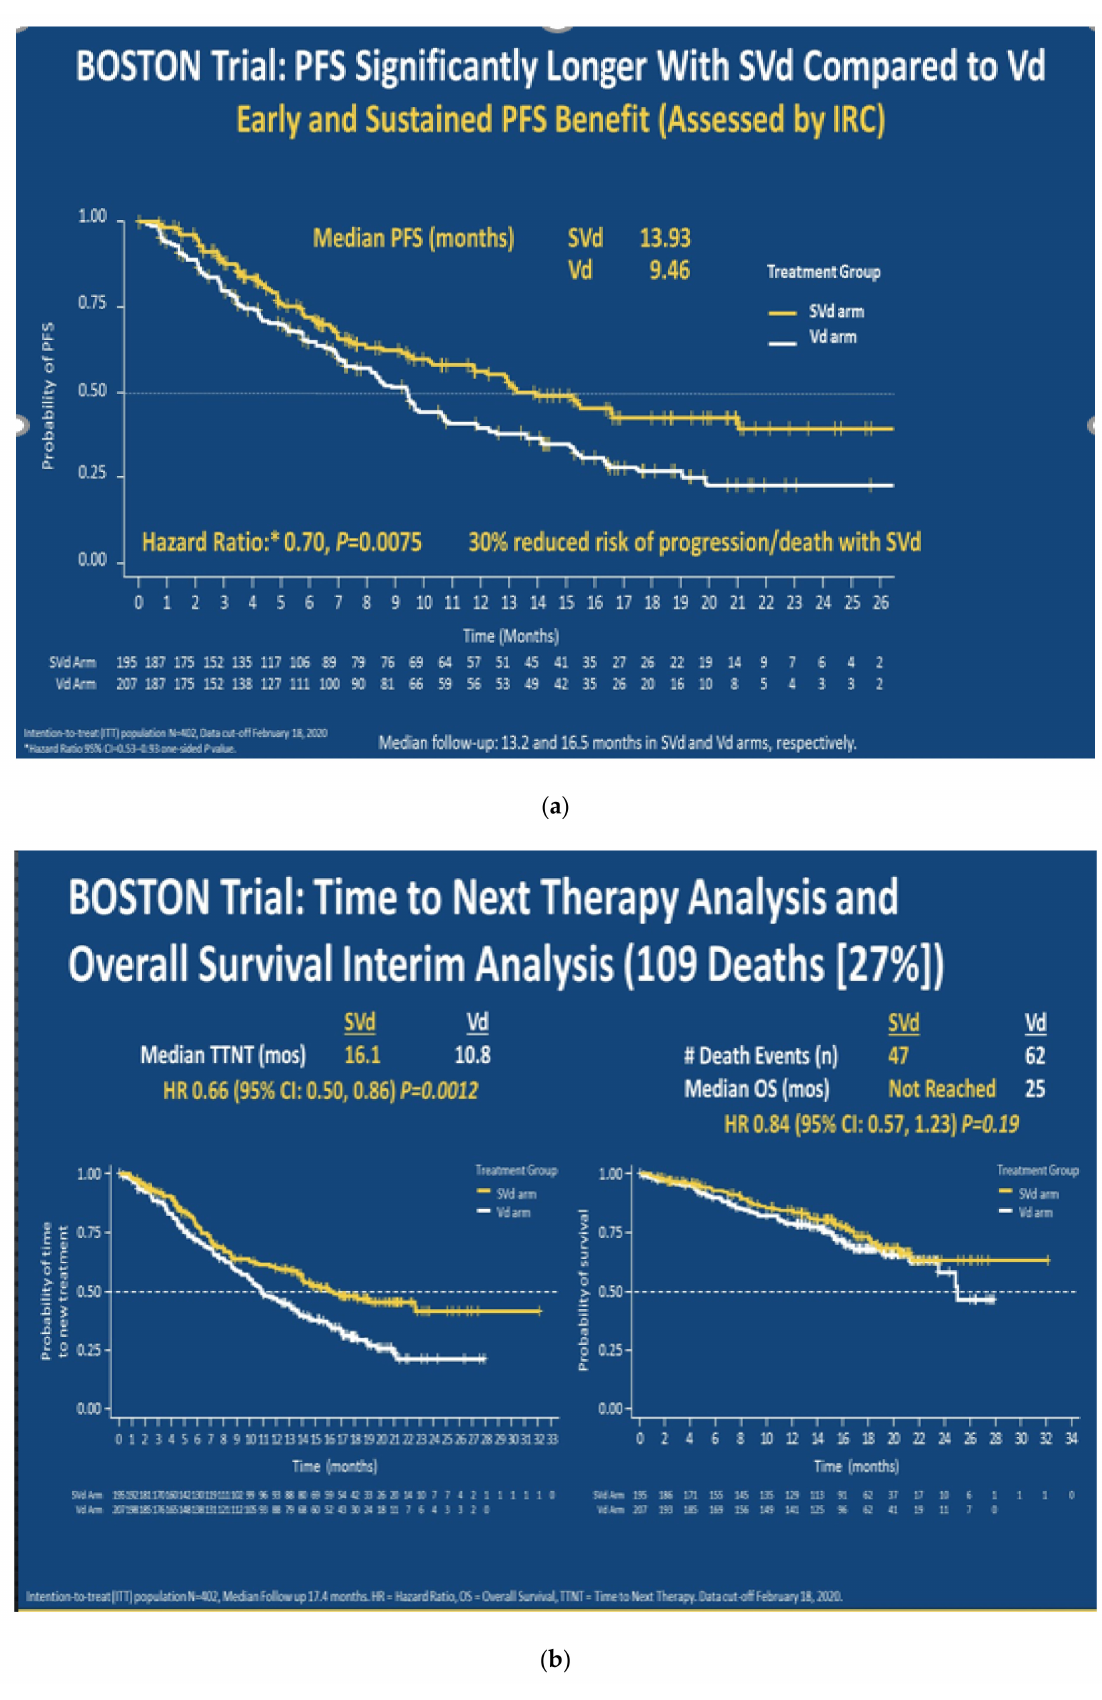
Figure 2. Outcomes of the BOSTON study. ( a ) Progression-free survival analysis ( b ) Time to next therapy and overall survival interim